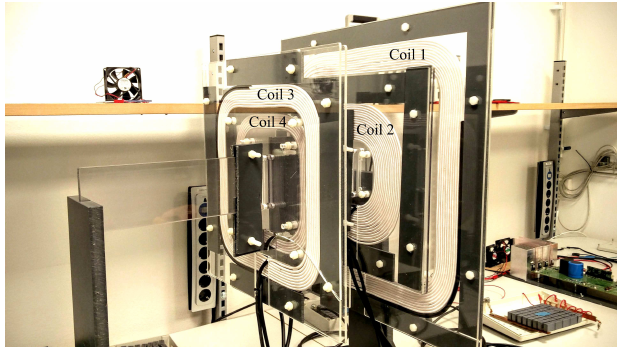
Fig. 1. Photo of the air-wound coils used in the WPT system prototype with four magnetically coupled